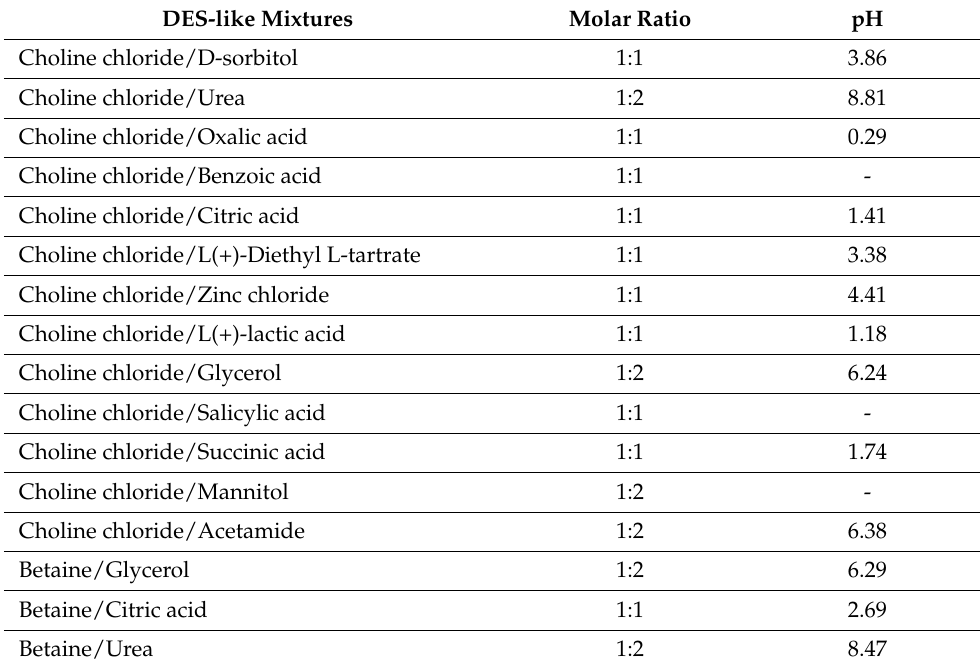
Table 10. The pH of the prepared DES-like mixtures was determined at 298 K for all 70 wt% of the aqueous solutions of the DES-like mixtures (adapted according to Cai et al.)